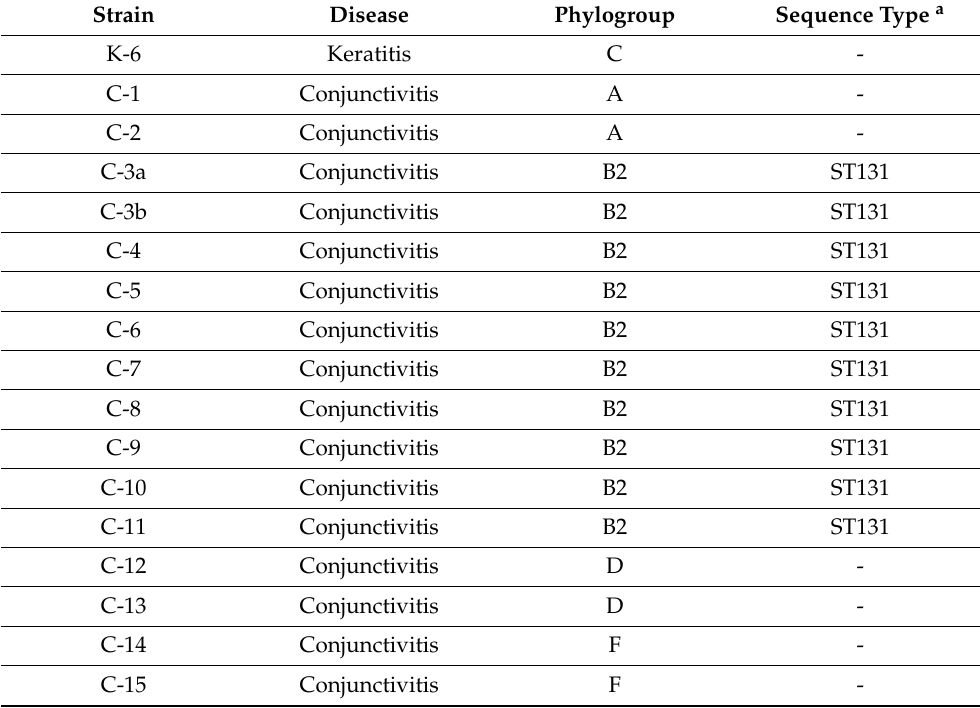
Table 1. Cont. Strain Disease Phylogroup Sequence Type a K-6 Keratitis